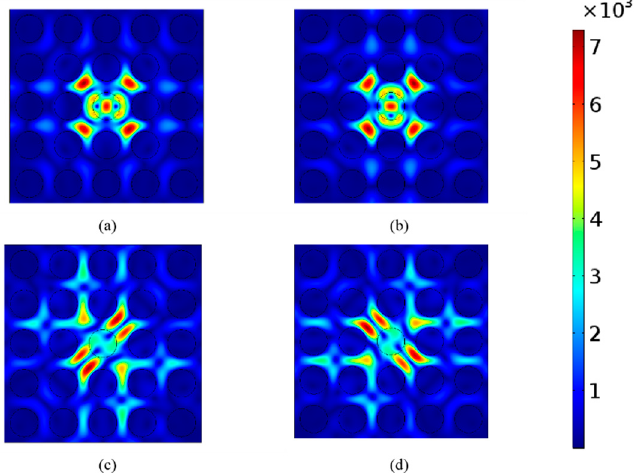
Figure 5. Displacement distributions of the point defect at the M point for σ z = 0 MPa, H z = 1 kOe. ( a ) NBG1 st is at ω a/2 π c t = 1.385799, ( b ) NBG2 nd is at ω a/2 π c t = 1.388351, ( c ) NBG3 rd is at ω a/2 π c t = 1.439993, and ( d ) NBG4 th is at ω a/2 π c t =